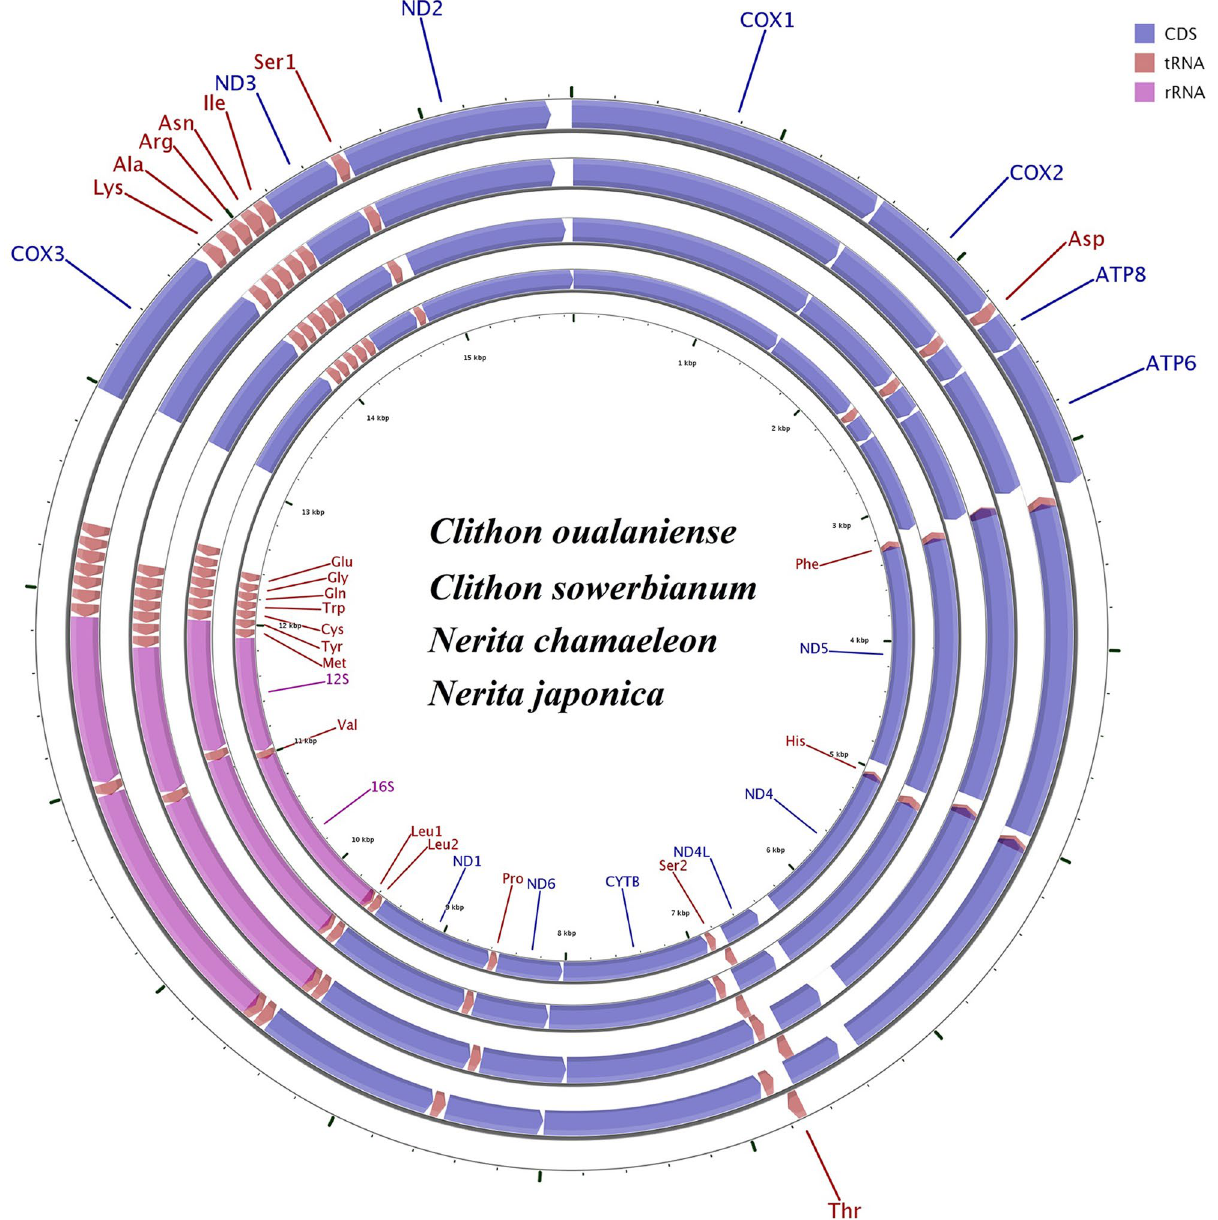
Figure 1. Gene map of the complete mitogenomes of Clithon oualaniense (GenBank accession No. MT568501), Clithon sowerbianum (MT230542), Nerita chamaeleon (MT161611) and Nerita japonica (MN747116). The ring indicates the gene arrangement and distribution. The largest ring is for C. oualaniense, and the smallest ring is for N. japonica . ND1-6 NADH dehydrogenase subunits 1–6, COX1-3 cytochrome c oxidase subunits 1–3, ATP6 and ATP8 ATPase subunits 6 and 8, CYTB cytochrome b, rRNA ribosomal RNA gene, tRNA transfer RNA